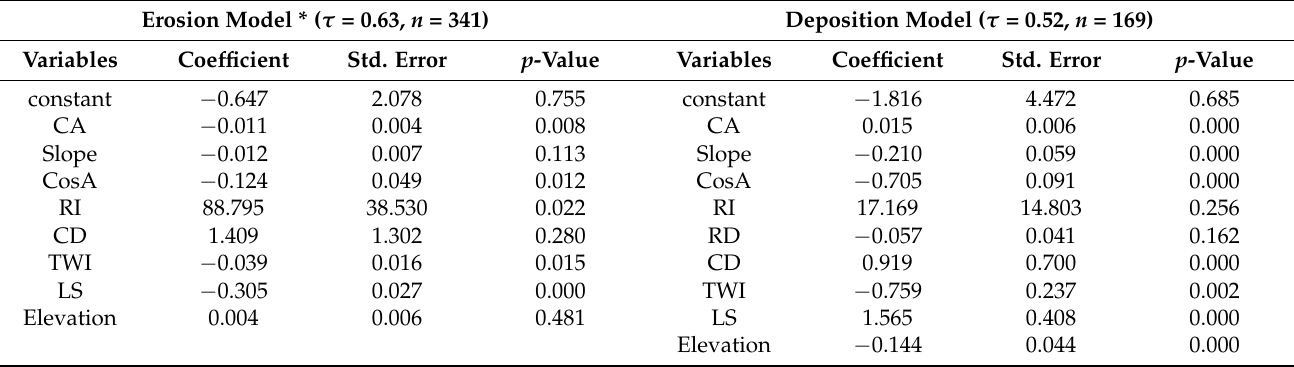
Table 7. Coefficients of the QR models for erosion and deposition (June–September